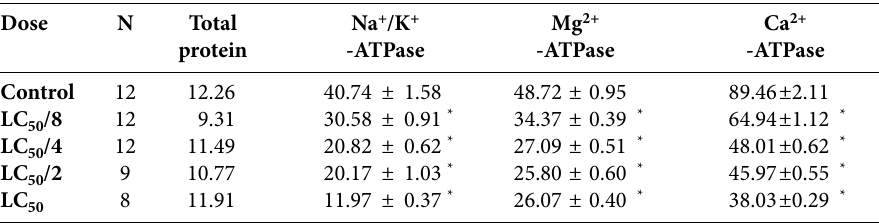
Table 4. Biochemical responses of 96-h Thmx exposure in gill. Total protein amount expresses as mg ml –1 , and enzyme activities expressed as µmol P i min –1 mg protein –1 ± mean standard error. Dose N Total Na + /K + Mg 2+ Ca 2+ protein -ATPase -ATPase -ATPase Control